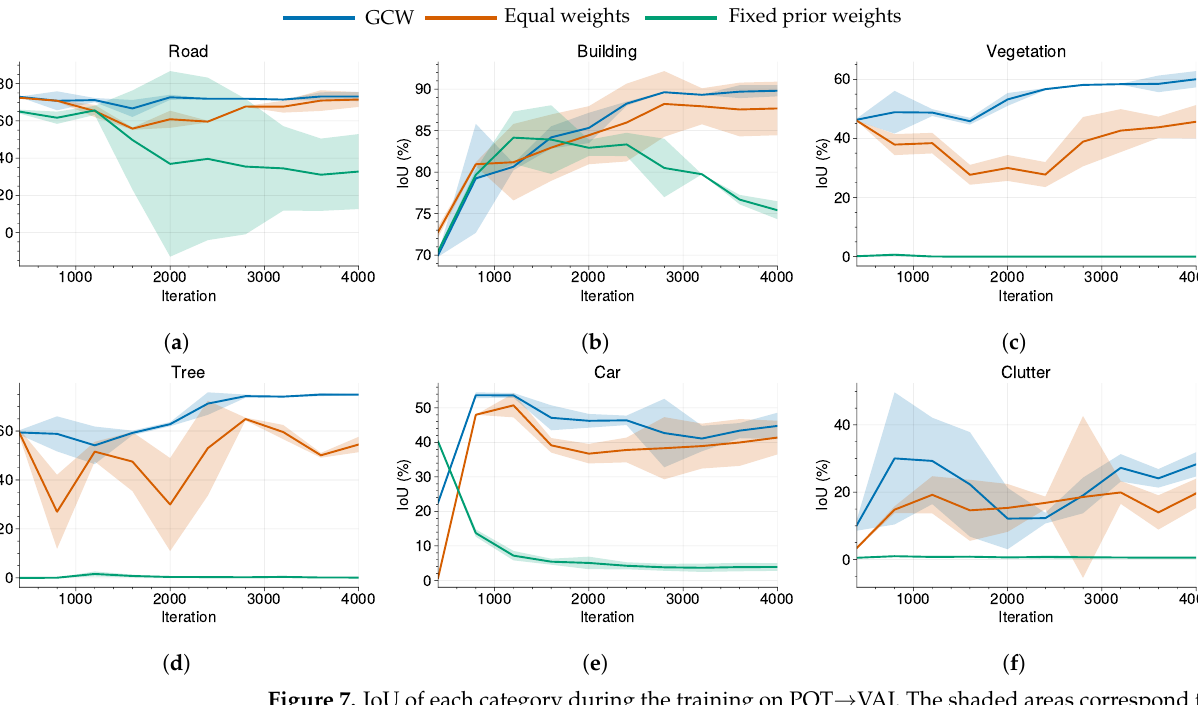
Figure 6. The weights of each category as calculated by GCW during the training on POT → VAI.